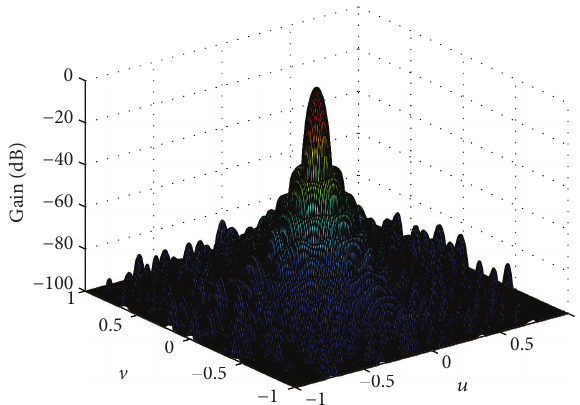
Figure 10: The beam pattern of planar circle array in surface plot.